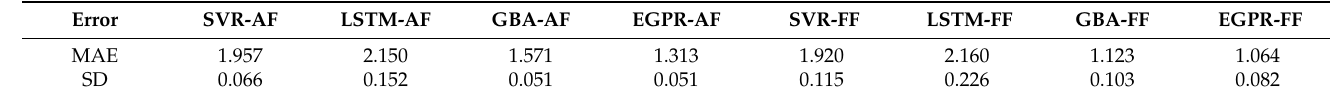
Table 4. The RR estimation results obtained using the dual signals based arithmetic fusion (AF) and feature fusion (FF) models are computed as the difference from the reference RR values to express it as the MAE and SD results.